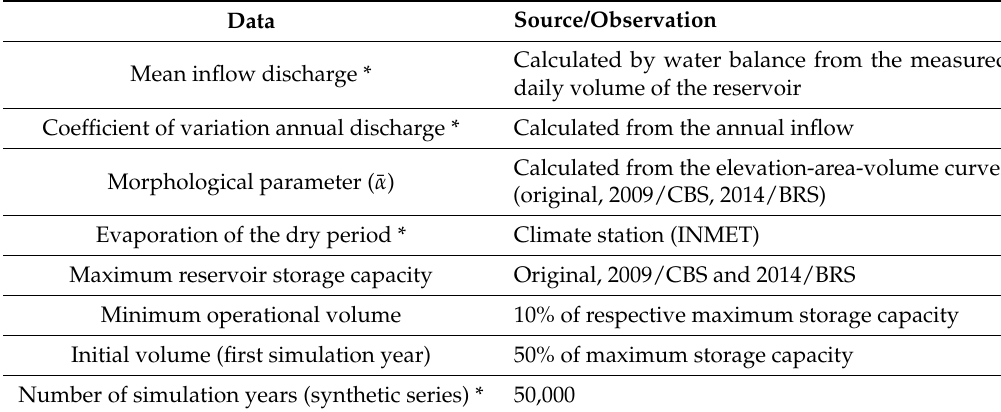
Table 2. Input data of the VYELAS model for the three scenarios of the Pentecoste reservoir. Symbol: * the same in the